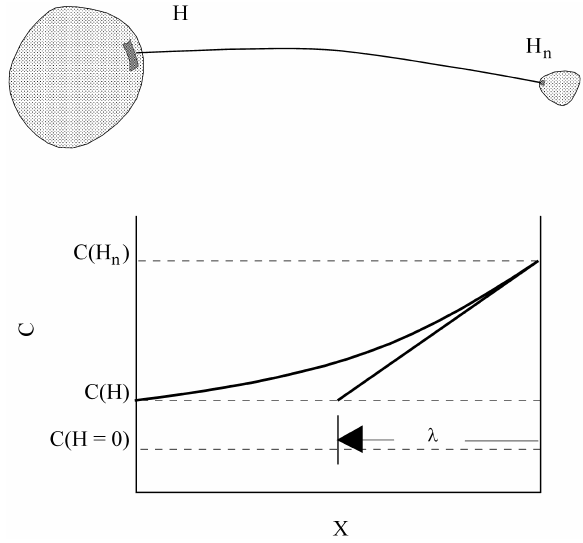
Figure 13. Illustration of the concentration profile along a flux line that joins two "communicating neighbors" surface elements and the associated diffusion lenght scale λ in diffusion controlled